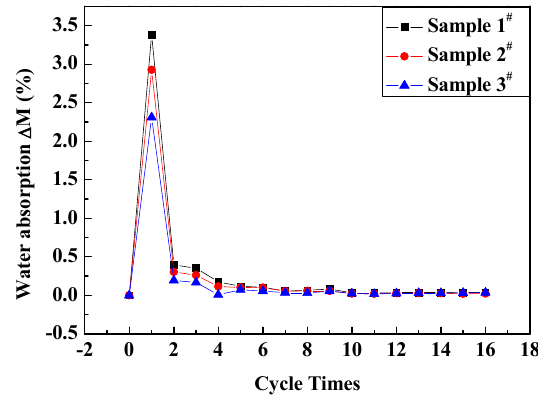
Figure 3. Water absorption curves.